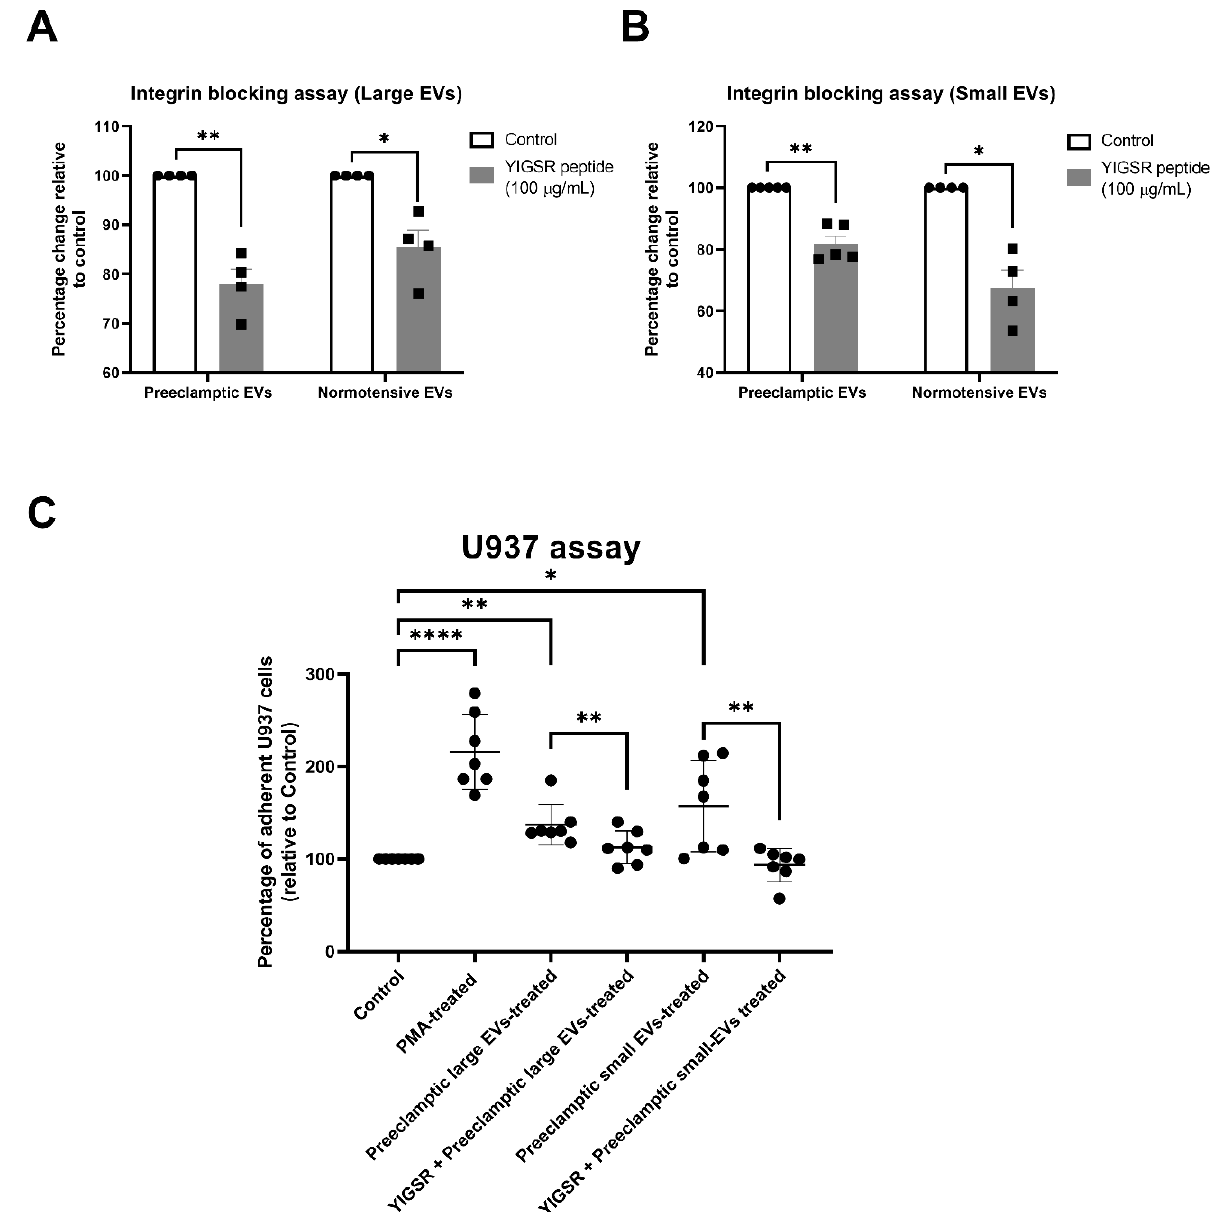
Figure 5. Blocking the integrin-mediated uptake of the preeclamptic placental EVs reversed their adverse effects on the endothelial cells. Fluorescently labelled placental ( A ) large EVs and ( B ) small EVs from preeclamptic placentae ( n = 5) or normal placentae ( n = 4), were pre-treated with the YIGSR integrin-blocking peptide (100 µg/mL). The interaction of the EVs with the HMEC-1 cells was quantified using a BioTek Synergy 2 microplate reader (Agilent, CA, USA). The YIGSR peptide significantly reduced the interaction of both the large and small EVs, from both the normotensive ( p = 0.025 and p = 0.024, respectively) and preeclamptic placentae ( p = 0.01 and p = 0.006, respectively). ( C ) Endothelial cell activation, in response to the large or small preeclamptic EVs, was measured by quantifying the adhesion of the fluorescently labelled U937 monocytes to the endothelial cells ( n = 7). Endothelial cells treated with PMA were used as a positive control for the activation. The increased activation of the HMEC-1 cells induced by both the large and small preeclamptic placental EVs, was inhibited by the preincubation with the YIGSR peptide. Values were normalized to the untreated HMEC-1 cells, and data are shown as mean ± SEM. Differences between the two groups were tested with a paired t -test (* p < 0.05, ** p < 0.01, **** p <